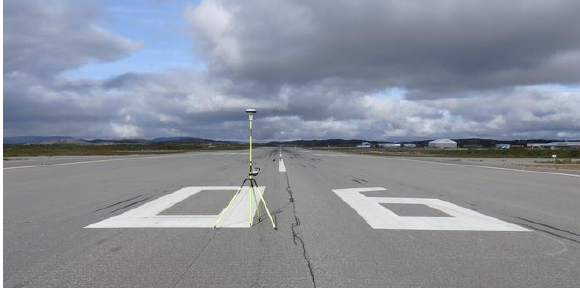
Figure 2: Ground Control Point (GCP) collection on the Airport